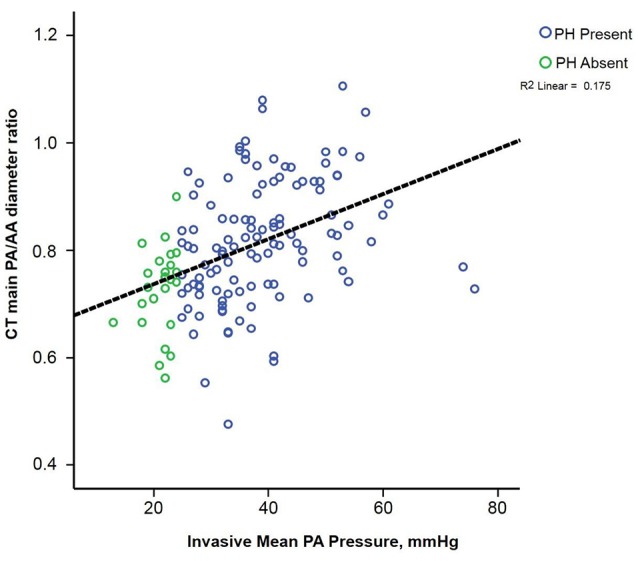
Scatterplot illustrating the correlation between the CT derived pulmonary artery/ascending aorta ratio.